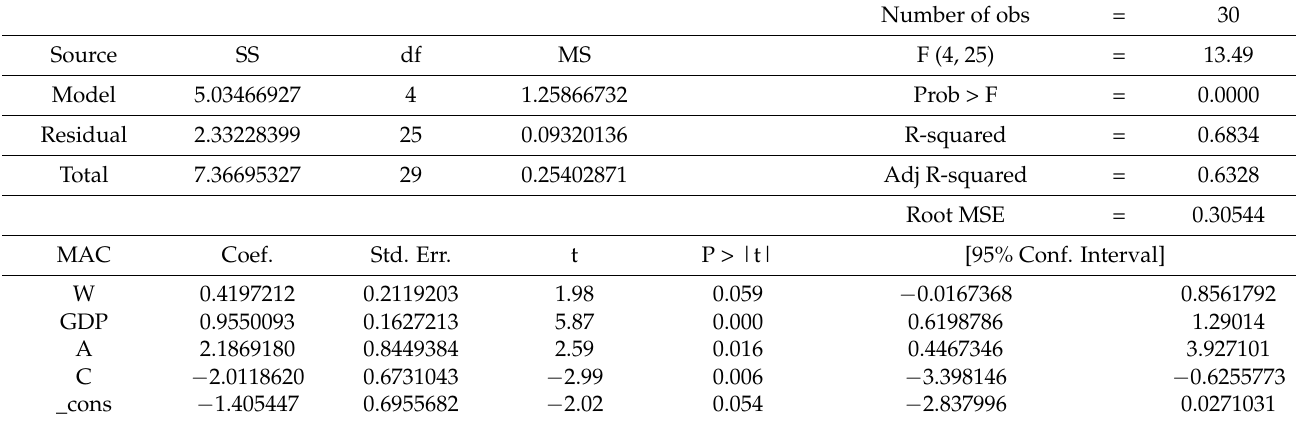
Table 3. Regression results of